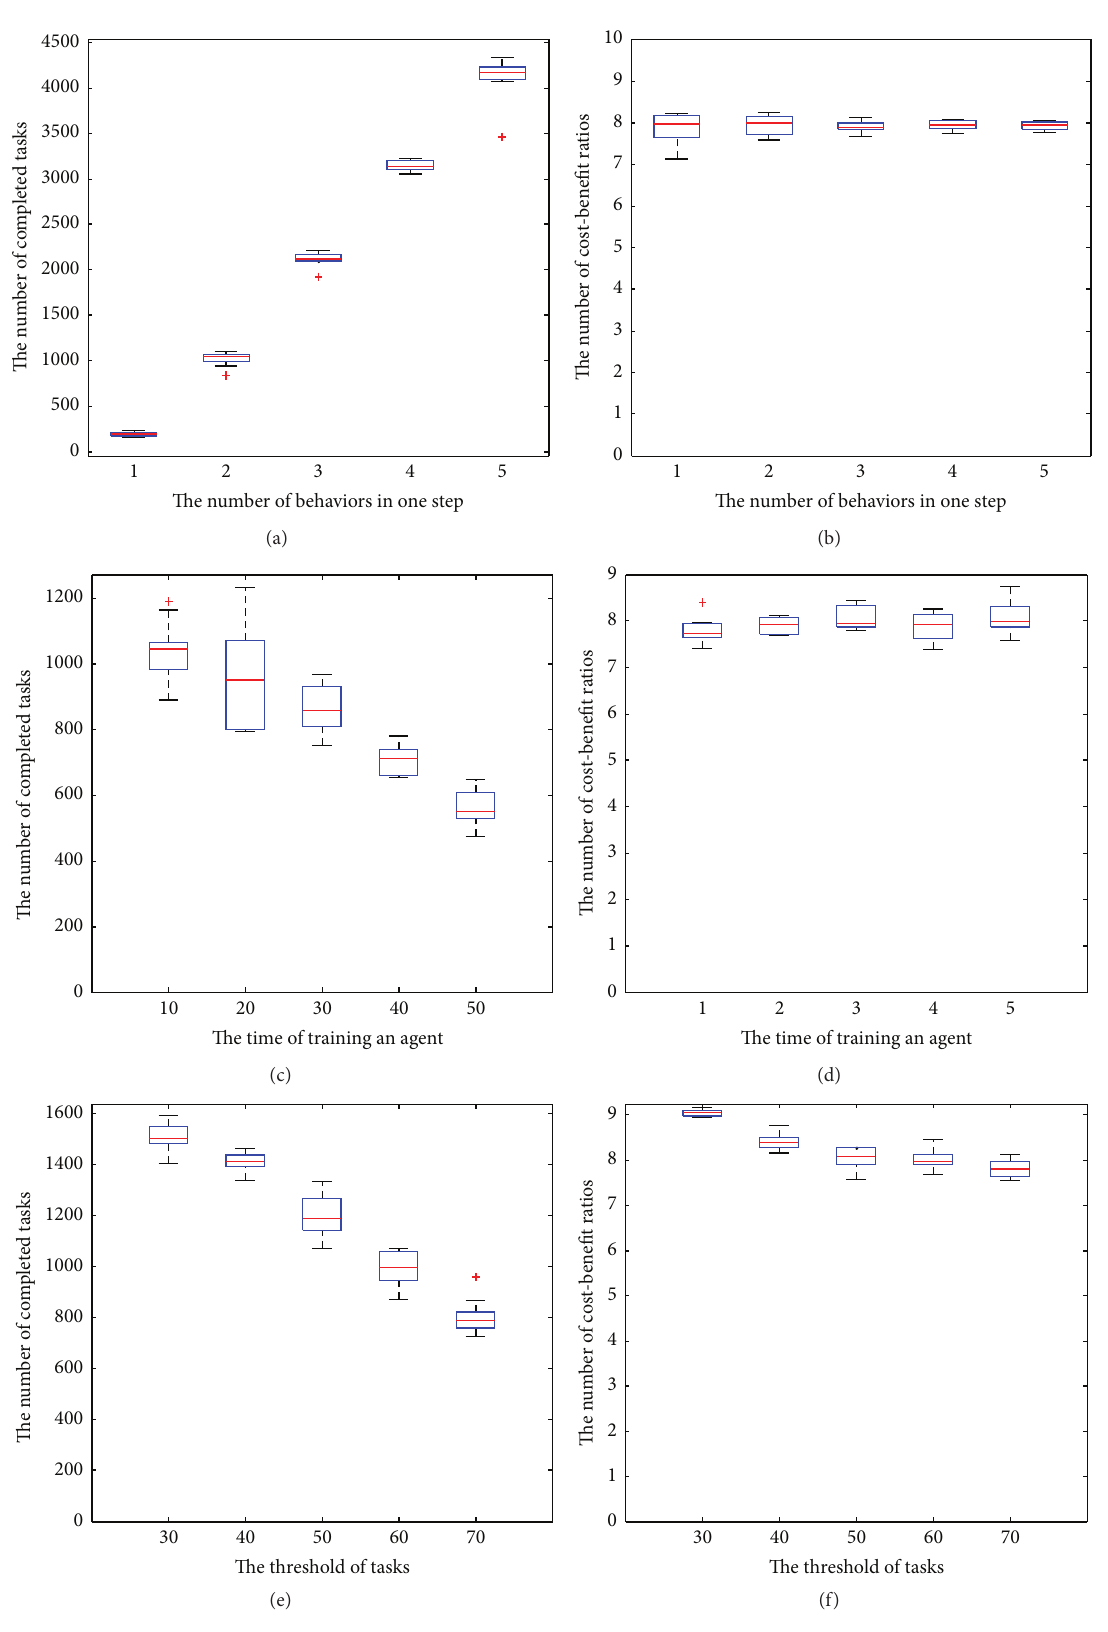
Figure 13: Simulation results of organizational performance with different (a)-(b) threshold of activities, (c)-(d) time of training, and (e)-(f) thresholds of